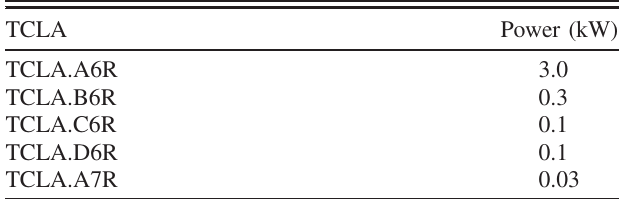
TABLE III. Total power taken by the active absorbers for 0.2 h BLT with total loss power of 1.86